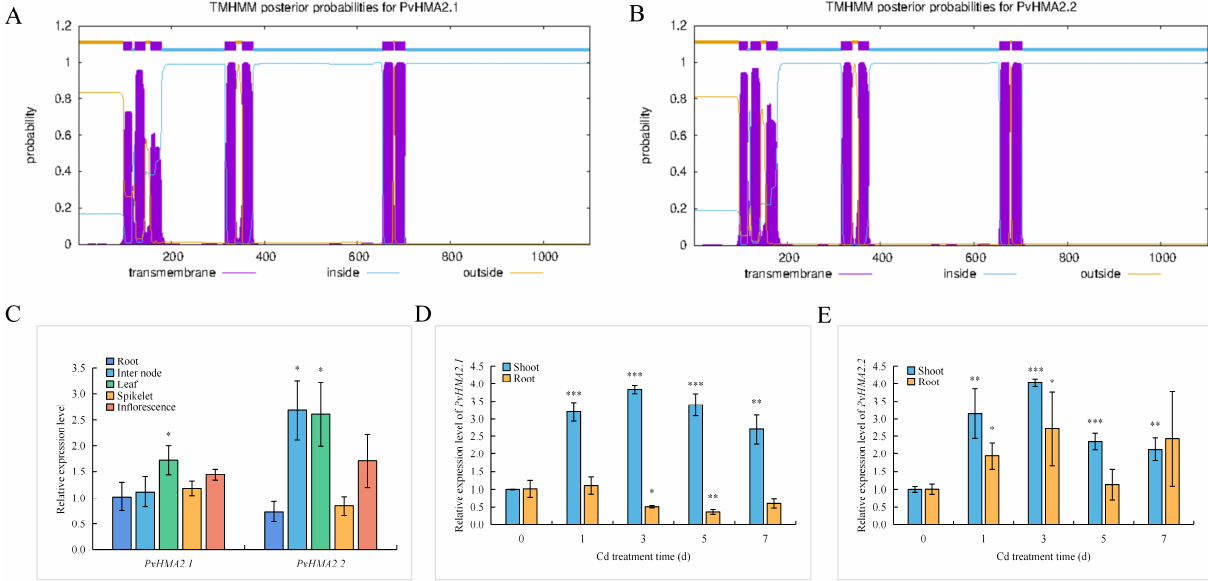
Figure 3. Protein transmembrane domain prediction and expression patterns of PvHMA2.1 and PvHMA2.2 . ( A , B ) Predictions of PvHMA2.1 ( A ) and PvHMA2.2 ( B ) protein transmembrane domains using TMHMM 2.0. The abscissa represents the amino acid sequence location. The ordinate represents the probability of the amino acids being located inside the membrane, outside the membrane, or in the transmembrane region. The purple parts represent the transmembrane helix structures, the blue parts represent the structures located inside the membrane, and the brown parts represent the structures located outside the membrane. ( C ) The relative expression levels of PvHMA2.1 and PvHMA2.2 in roots, internodes, leaves, spikelets, and inflorescences of P. virgatum Alamo. PvHMA2.1 gene expression levels in roots are normalized as 1. ( D , E ) The relative expression levels of PvHMA2.1 ( D ) and PvHMA2.2 ( E ) in shoots and roots in response to a time-course cadmium (Cd) treatment. Specifically, 14-day-old switchgrass seedlings were grown in a 1/4 Hoagland’s nutrient solution without Cd (as the control) or with 50 µ M of Cd for 7 days. The transcript levels of PvHMA2.1 and PvHMA2.2 under the control condition are normalized as 1. Switchgrass Ubiquitin expression is used as an internal reference, and the primers used for the qPCR are listed in Supplementary Table S2. Error bars represent the standard deviations of the three replicates. Asterisks indicate significant differences between the treatment group and the control group: one asterisk indicates p < 0.05, two asterisks indicate p < 0.01, and three asterisks indicate p < 0.001.